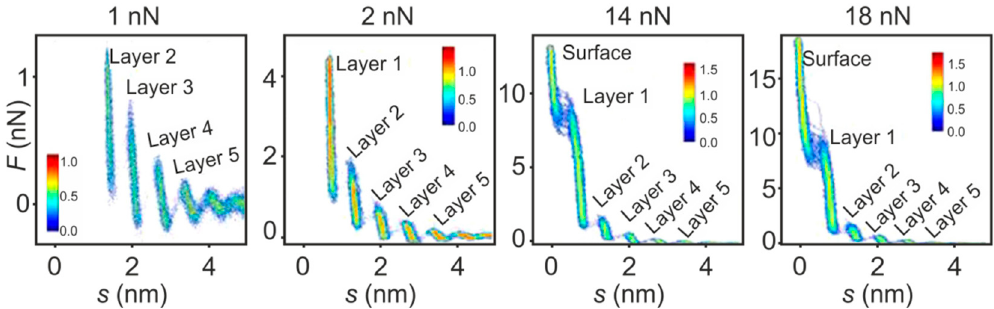
Figure 9. Force–separation curves measured during approach of the [EMIm][TFSI]/mica interface using different force set points. The 2D histograms were calculated using 50 curves. Adapted from Black et al. [20].